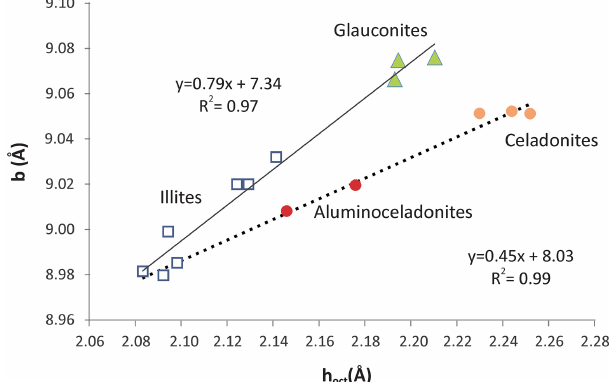
Figure 11. Relationship between the mean thickness of the octahe- dral sheet and b parameter of illites (squares), aluminoceladonites (red circles), celadonites (orange circles) and glauconites (green tri- angles). Data from Drits et al.